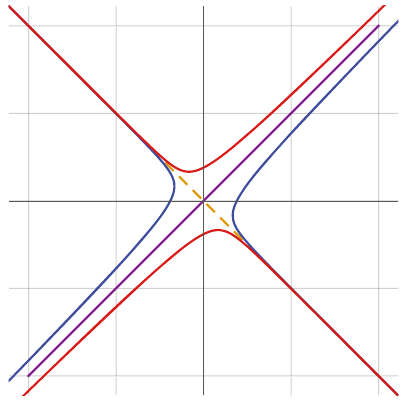
Figure 14: Spacelike ( blue ) and timelike ( red ) elastic curves in (cid:2) 2 with = = σ E 0